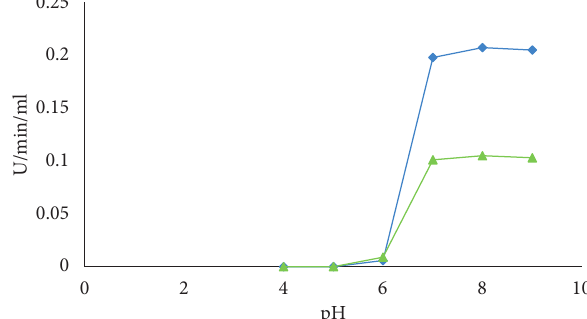
Figure 3: Optimum pH incubation of B. licheniformis (blue) and B. cereus (green) for amylase